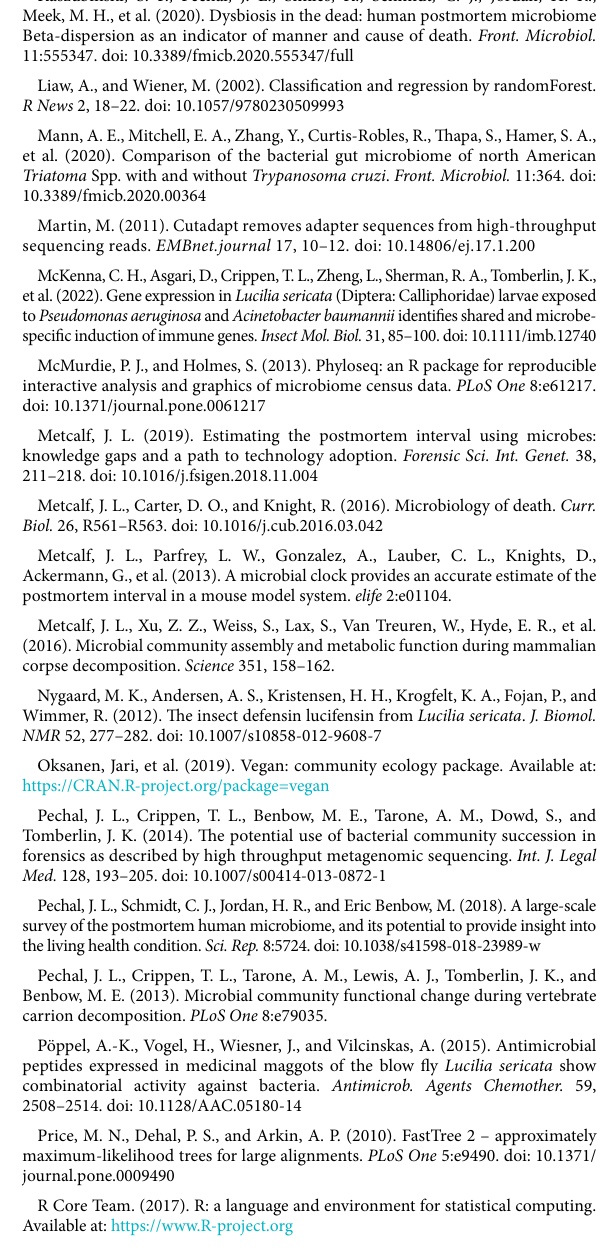
presence of insects on the remains but not at sample site, y, insects present at sample site. SUPPLEMENTARY FIGURE 6 Increased alpha diversity and decreased community cohesion in later stages of decomposition. (A) Increase in alpha diversity (Observed ASVs & Shannon diversity) over time since placement in the field. (B) Changes in beta diversity by the number of days since placement in the field. SUPPLEMENTARY FIGURE 7 Percent abundance results of four phyla interrogated using qPCR and sequencing in two seasons. The relative abundance of